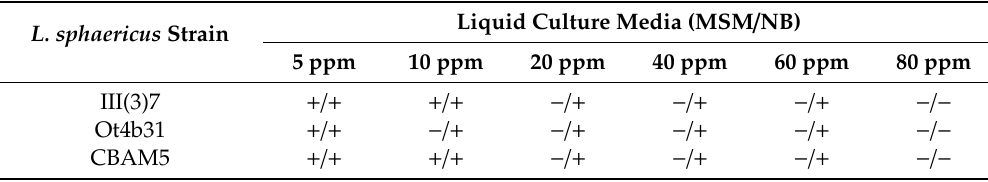
Table 2. MIC of HgCl 2 on L. sphaericus